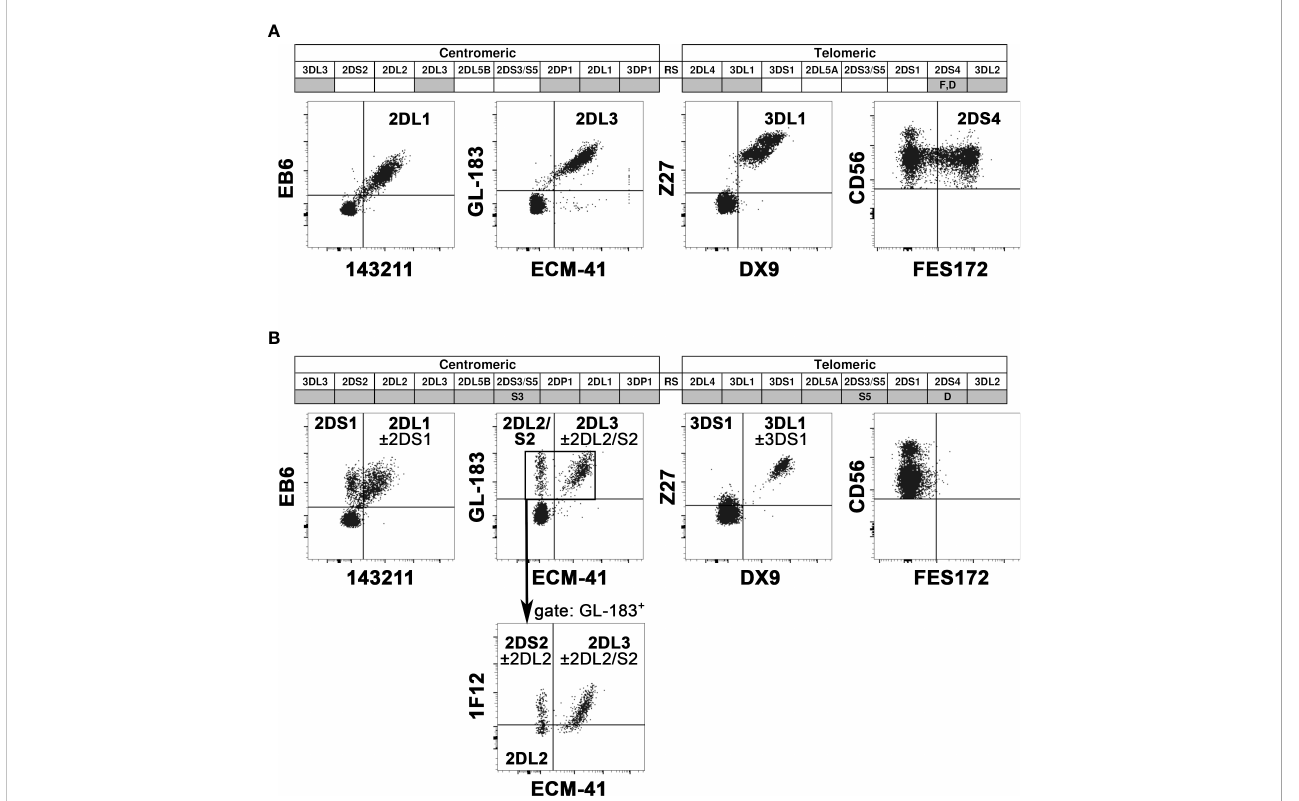
FIGURE 2 Representative analyses of KIR gene pro fi les and KIR phenotype. In the KIR gene pro fi les (top), the KIR presence or absence is indicated with grey or white boxes, respectively. KIR2DS4 alleles coding for surface receptors are reported as F, while those coding for truncated receptors as D. KIR2DS3 and KIR2DS5 are indicated by S3 and S5, respectively. Cyto fl uorimetric analysis of PBMC (bottom) shows the surface expression of various iKIR and aKIRs on NK cells (gating on CD3 − CD56 + cells), using different mAb combinations (see mAb speci fi city in Supplementary Table 1). The “ KIR ” acronym has been omitted for both genes and molecules. Two representative donors were evaluated. (A) D1 of patient #12 was characterized by KIR A/A genotype and the expression of all analyzed iKIR, and only KIR2DS4 as aKIR. (B) D2 of patient #8 was characterized by KIR B/x genotype, and the expression of all detectable iKIR and aKIR (excepted KIR2DS4). Gating on GL183 + NK cells, 1F12/ECM-41 mAb combination also allowed the discrimination of KIR2DS2 + , KIR2DL2 + , and KIR2DL3 + NK cell